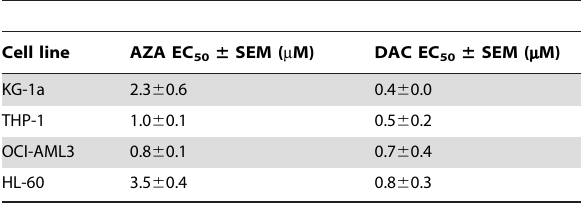
Table 1. AZA and DAC potencies on acute myeloid leukemia cell